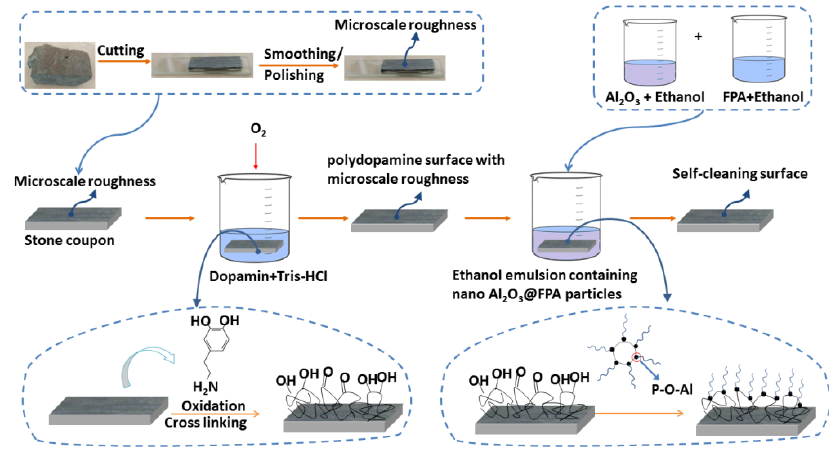
Figure 1. Schematic illustration of the processes to render self-cleaning stone surface via formation of polymerized dopamine layer of the stone surface and coating of Al 2 O 3 particles derivatized with self-assembled monolayers of a fluorophosphonic acid (denoted as Al 2 O 3 @FPA).